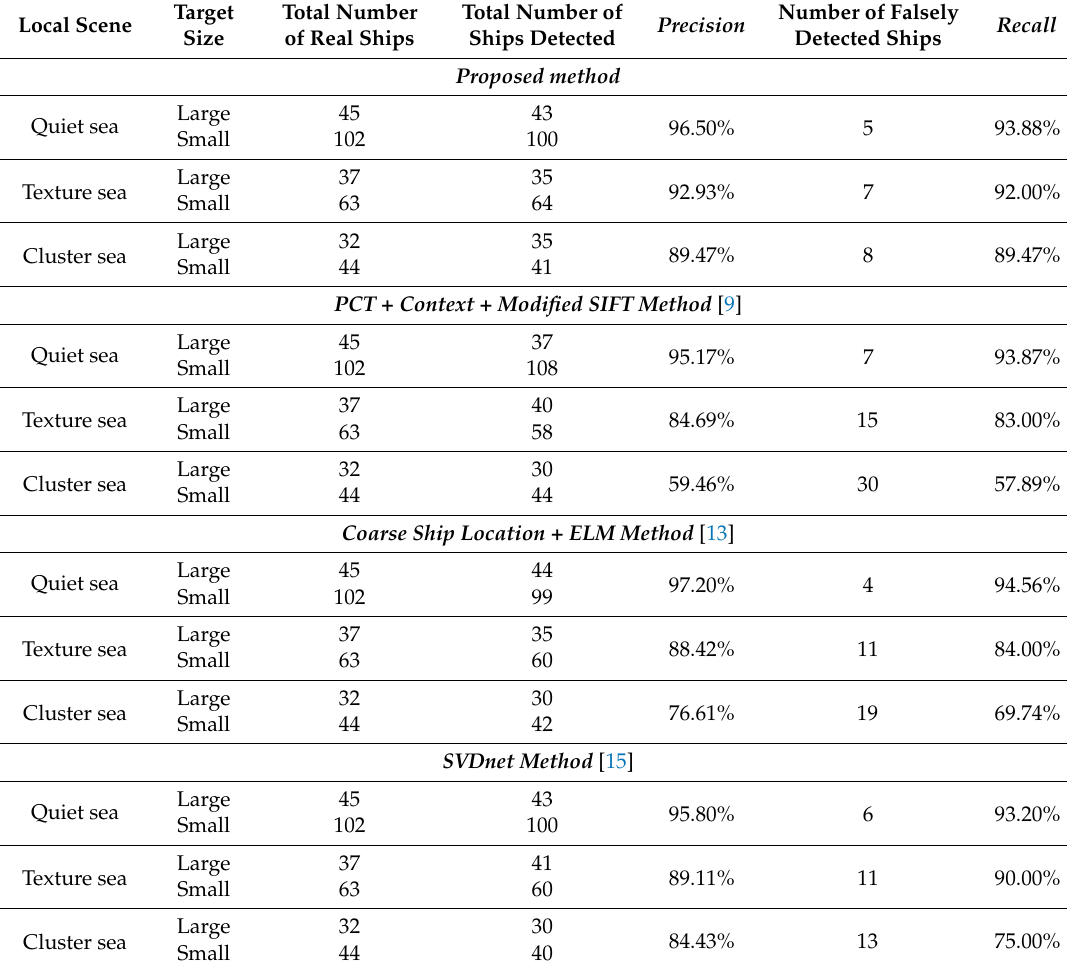
Table 6. Detailed analysis and comparison with state of the art